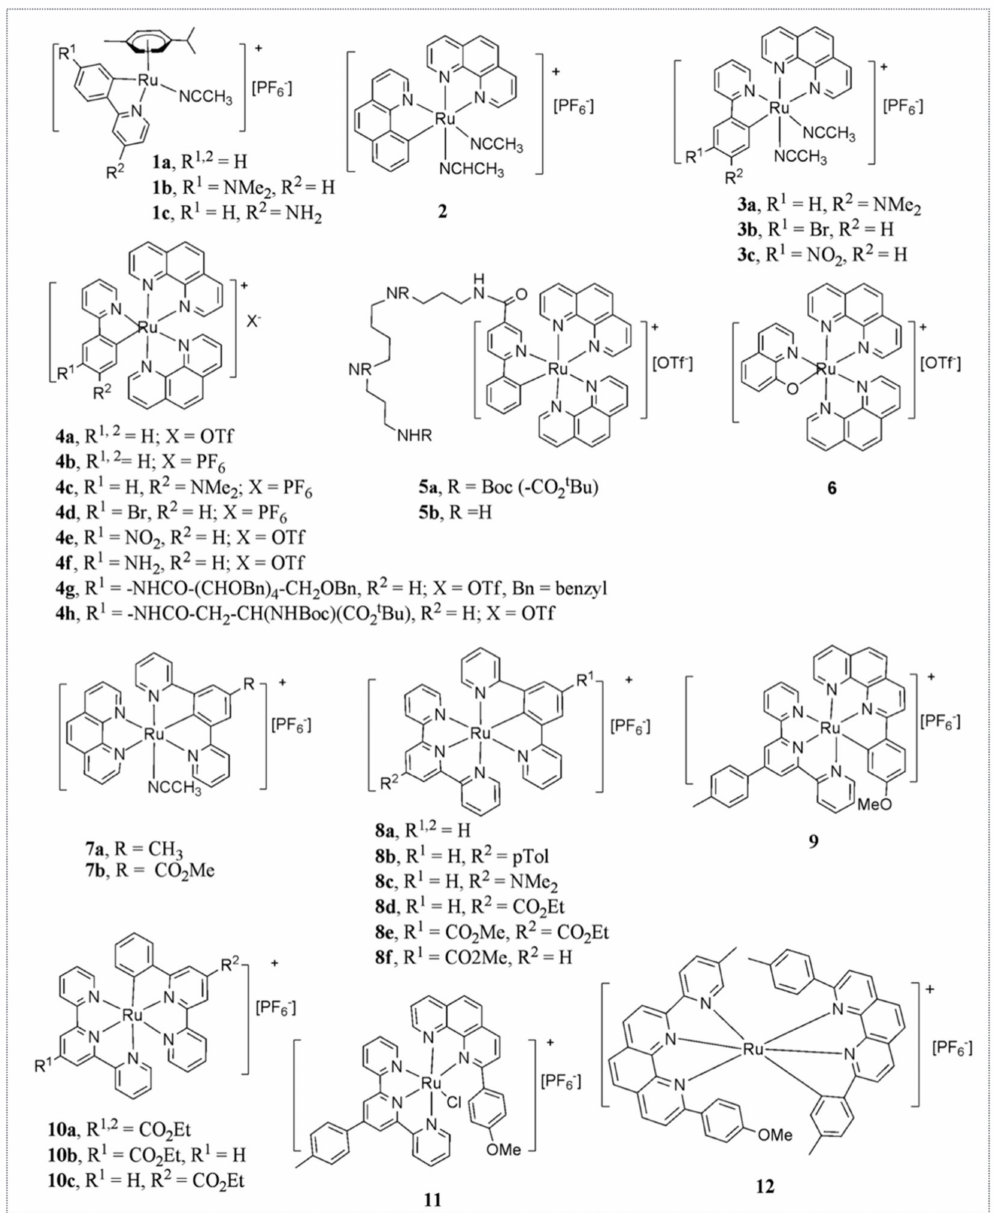
Figure 5. Examples of ruthenium organometallic complexes that induce the ER stress pathway. Second generation of RDC synthesized by the Dr. Pfeffer and tested for their biological